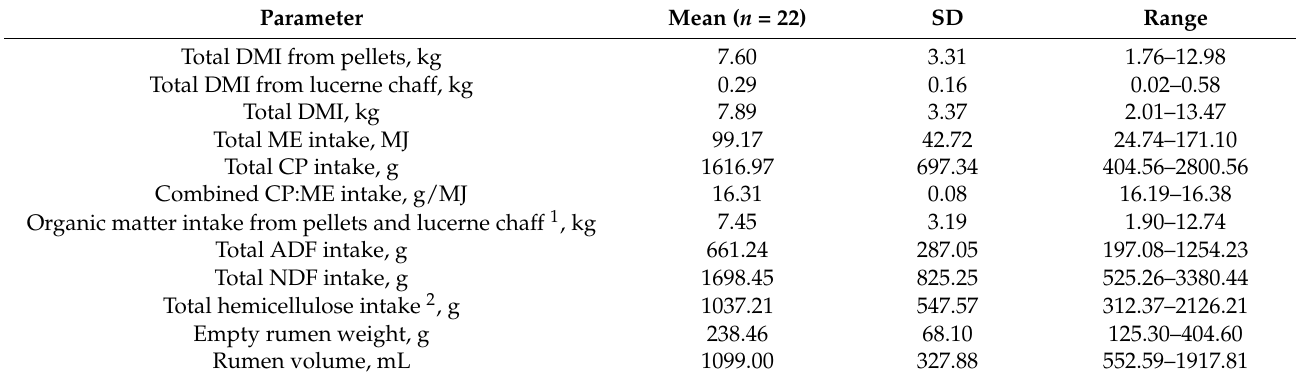
Table 2. Overall means, standard deviation (SD), and range for pellet, lucerne chaff and nutrients intakes, empty rumen weight, and rumen volume of the lambs included in the study (DMI, dry matter intake; ME, metabolisable energy; CP, crude protein; ADF, acid detergent fibre; NDF, neutral detergent